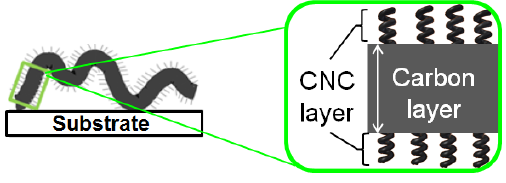
Figure 11. Illustration of the carbon